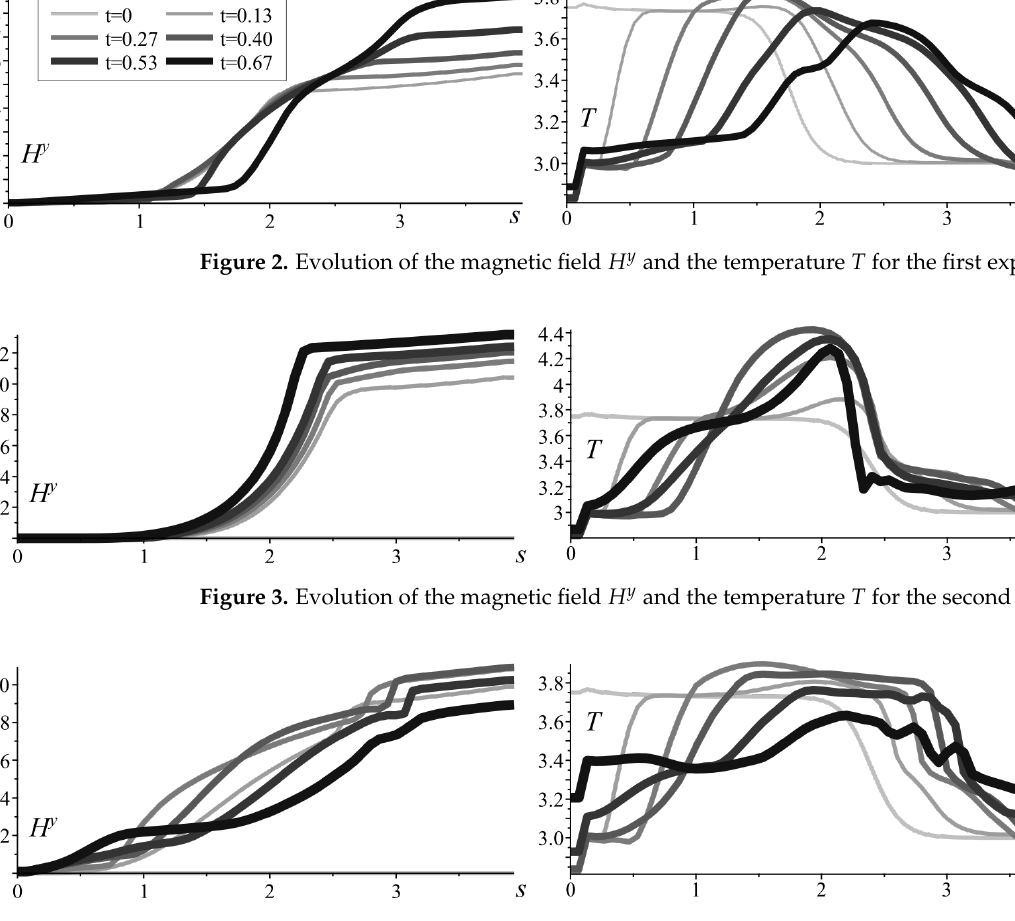
Figure 4. Evolution of the magnetic field H y and the temperature T for the third